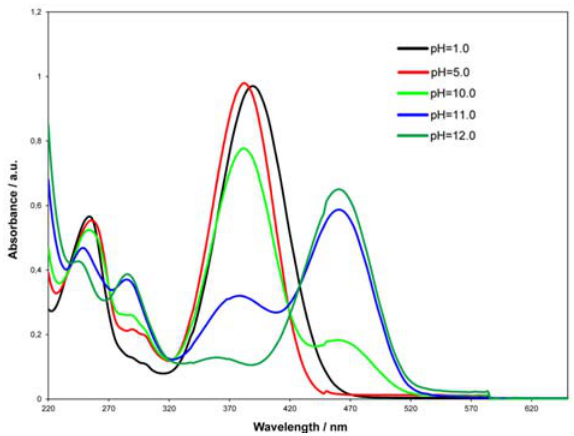
Fig. 1. Absorbance spectra of ITHBA at different pH